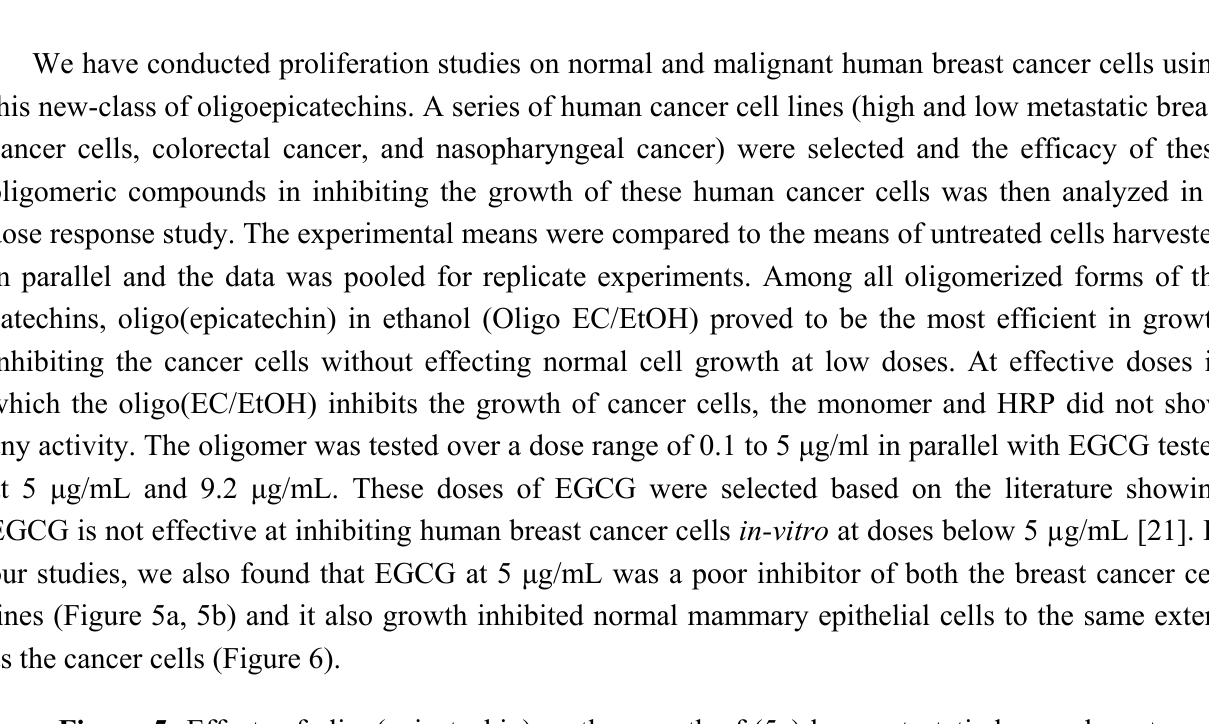
Figure 5. Effects of oligo(epicatechin) on the growth of (5a) low metastatic human breast cancer cells (5b) high metastatic human breast cancer cells (5c) normal cells [p values <0.05(*) or